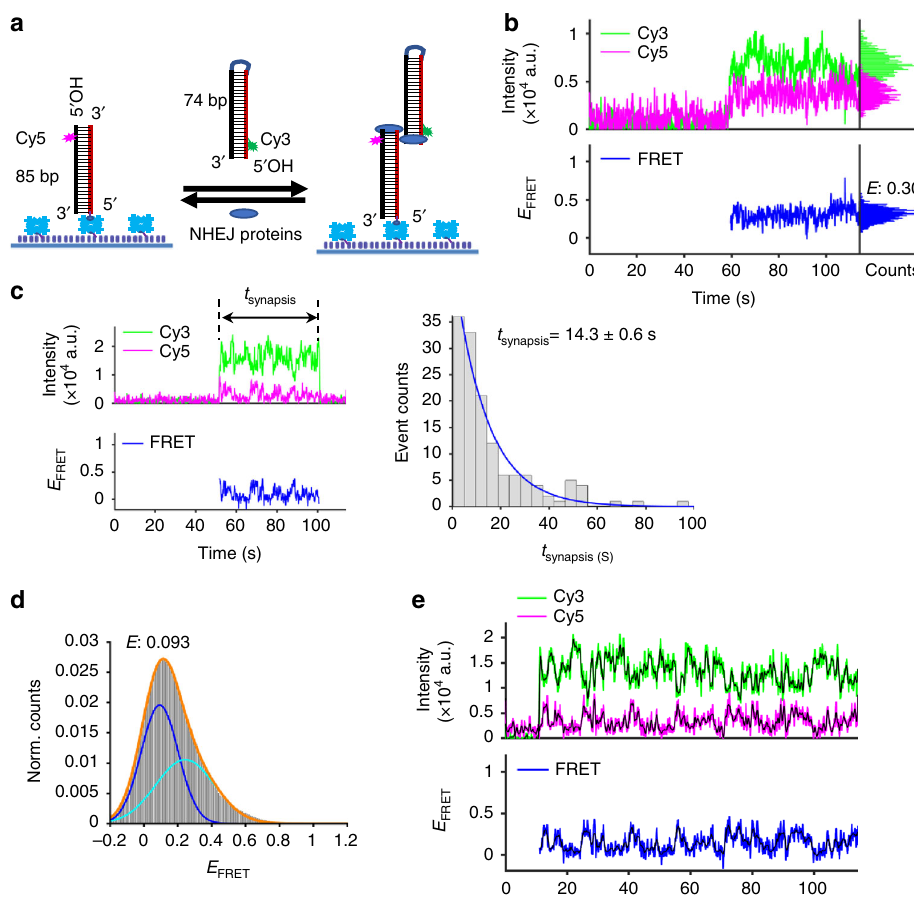
Fig. 1 Ku and X4L4 can mediate ef fi cient noncovalent synapsis of blunt dsDNA ends. a Schematic of the smFRET assay for blunt end synapsis. An 85 bp duplex with a terminal 5 ′ -OH and a Cy5 dye located 4 bp away from the end was immobilized on the surface of the imaging coverslip. The 74 bp incoming dsDNA with a terminal 5 ′ -OH and a Cy3 dye located 4 bp away from the end was added to the reaction via an injected solution that also contained 25 nM Ku and 50 nM X4L4. The fi gure illustrates a lateral con fi guration that may permit movement of the duplexes along one another [rather than an end-to-end con fi guration (see below)]. b Representative single-molecule time traces of donor (green) intensity, acceptor (magenta) intensity, and the corresponding E FRET values (blue) for synapsis mediated by Ku and X4L4. Histograms of donor intensity (green), acceptor intensity (magenta), and within synapsis period are indicated at the right part of the fi gure. c Left panel: representative trace for dwell time (t synapsis ) calculation. Right panel: histogram and corresponding exponential fi t of total synapsis time mediated by Ku and X4L4. Cy3 signal lifetime (including zero-FRET and detectable FRET portions) of the synaptic complex was used to calculate the total dwell time for each synapsis event and only the synapsis events ( n = 139) with both start and end time points within the detection time window were included. Synapsis time shown on graph is represented as mean ± SD of two replicates. d Histogram of E FRET values of all synapsis events mediated by Ku and X4L4. The E value shown on the graph was obtained from a Gaussian fi t of the highest peak. n = 515 molecules. e One of the dynamic intensity traces (donor: green; acceptor: magenta) and corresponding E FRET values (blue) of synapsis mediated by Ku and X4L4. The black line represents the smoothed trace of corresponding donor, acceptor, or E FRET trace. Source data are provided as a Source Data1 fi